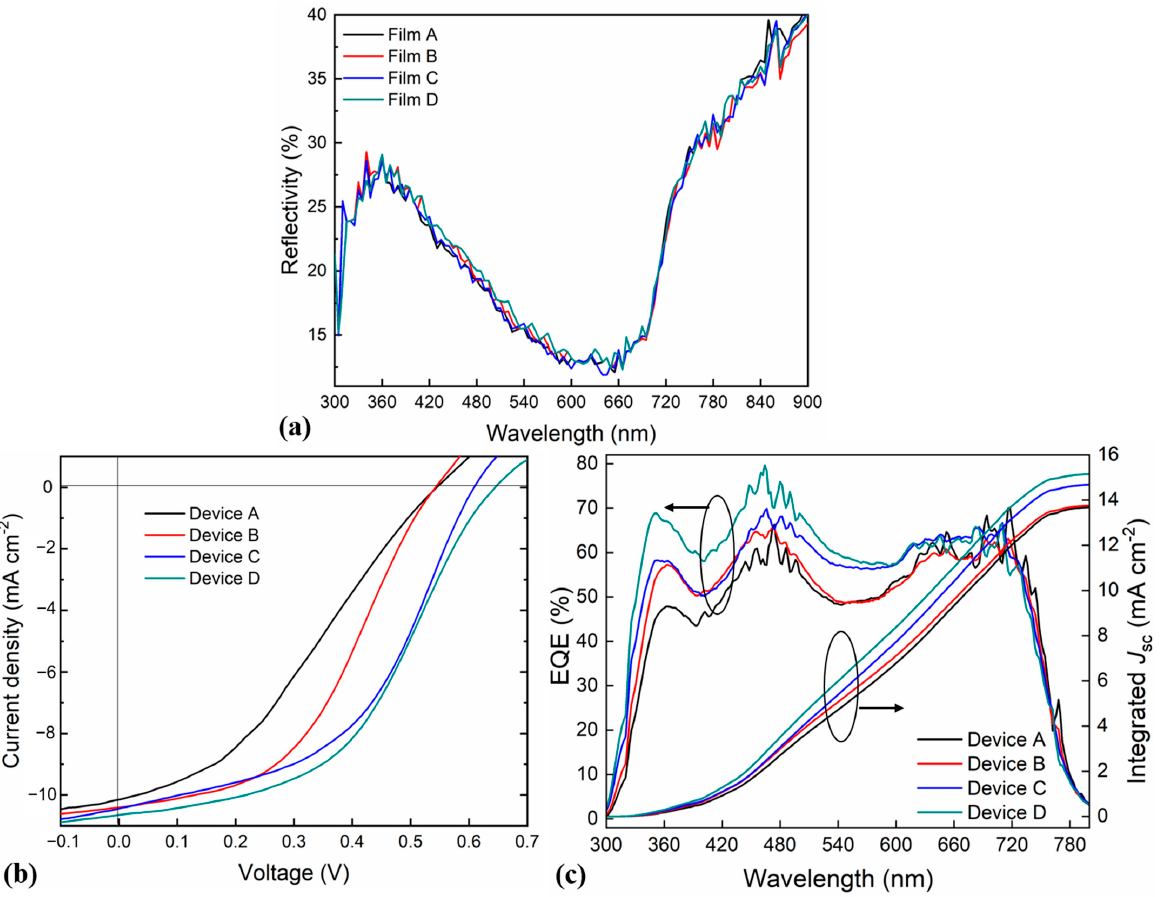
Figure 2. ( a ) The reflectivity test of Films A, B, C, and D. ( b ) The JV characteristic curves and ( c ) EQE and integrated J sc analyses of Devices A, B, C, and D.